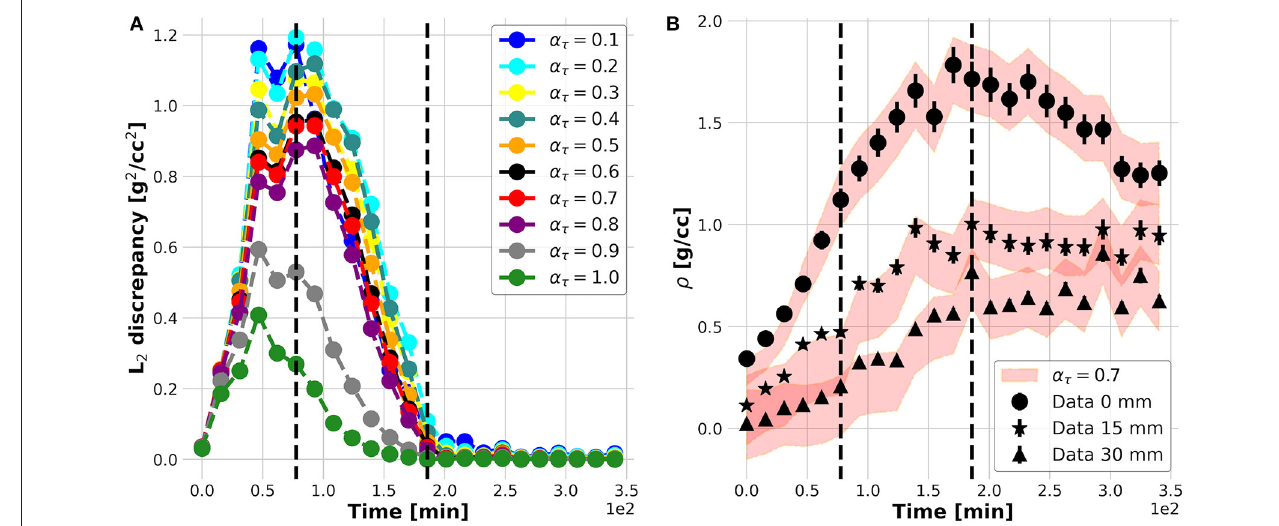
FIGURE 3 | L 2 discrepancy between model prediction (filled red band) and data (markers) for different α τ (A) ; measured (filled dots) and predicted (red bands) time profiles at three equally spaced positions along the plant stem (B) .